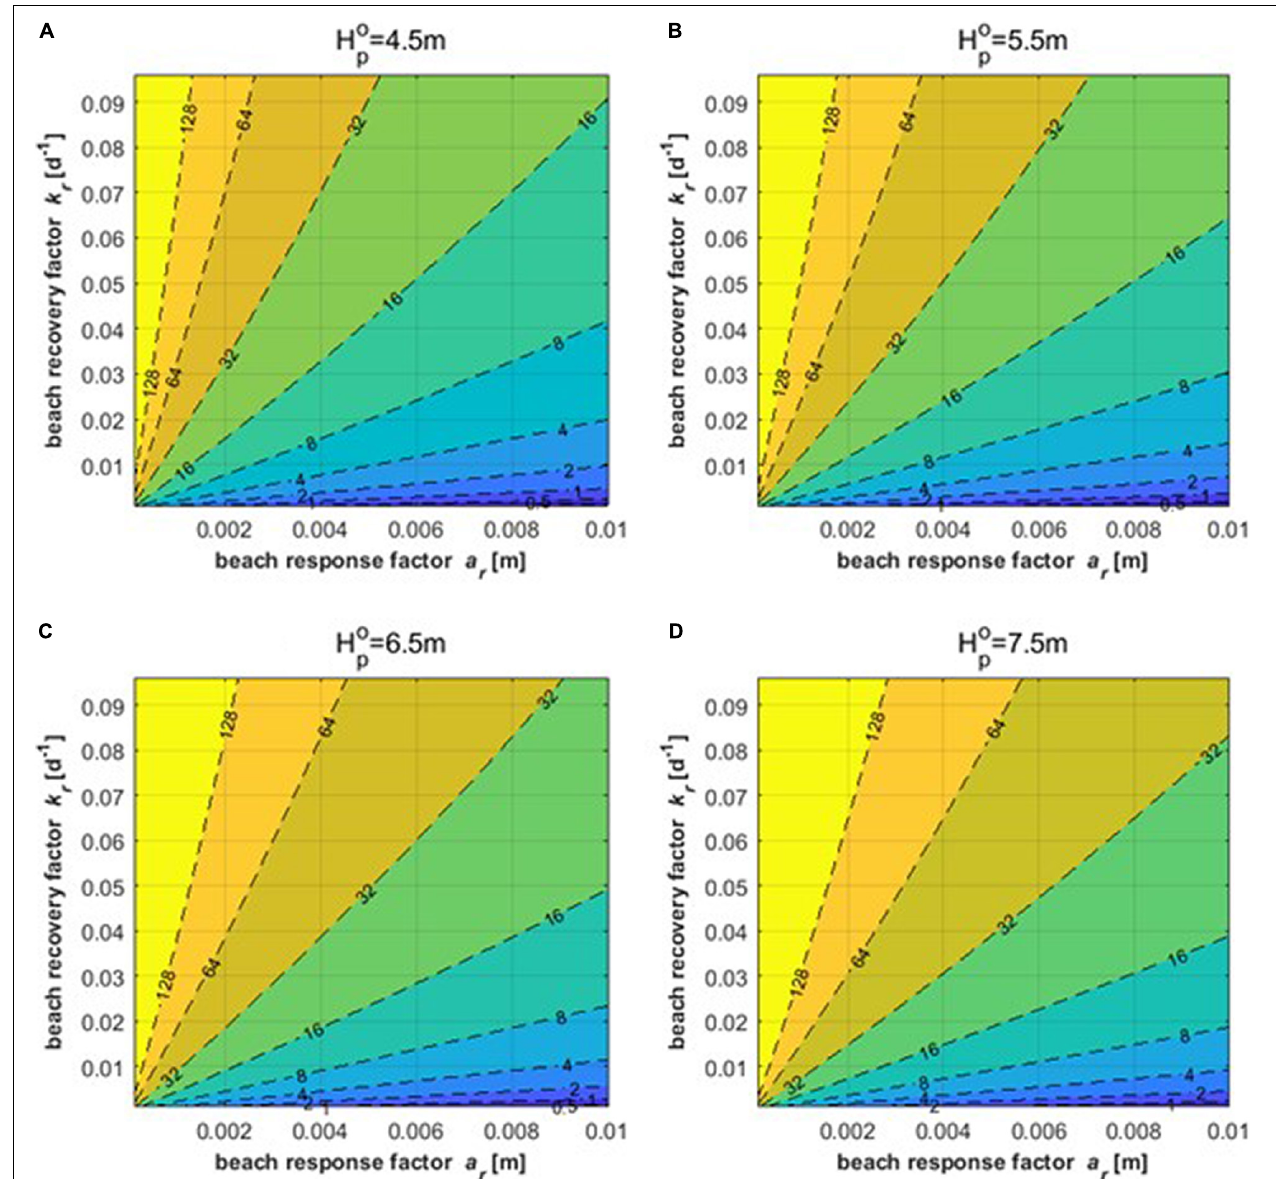
FIGURE 7 | Results of peak SL retreat width according to beach response factor a r ( m ) and beach recovery factor k r ( d − 1 ) for (A) H o p = 4 . 5 m , (B) H o p = 5 . 5 m , (C) H o p = 6 . 5 m , and (D) H o p = 7 . 5 m